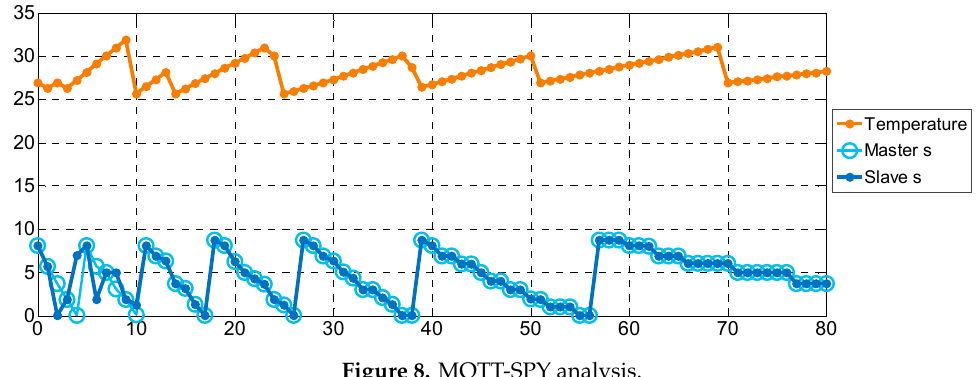
Figure 7. Synchronization CS-ABE flow chart.